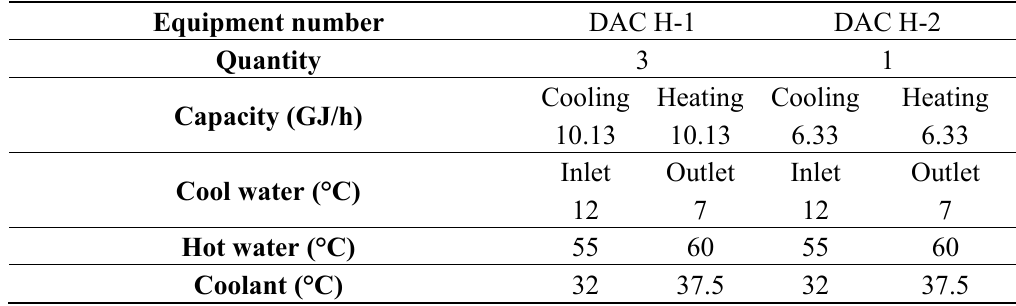
Table 4. Absorption (ABS) chiller-heater